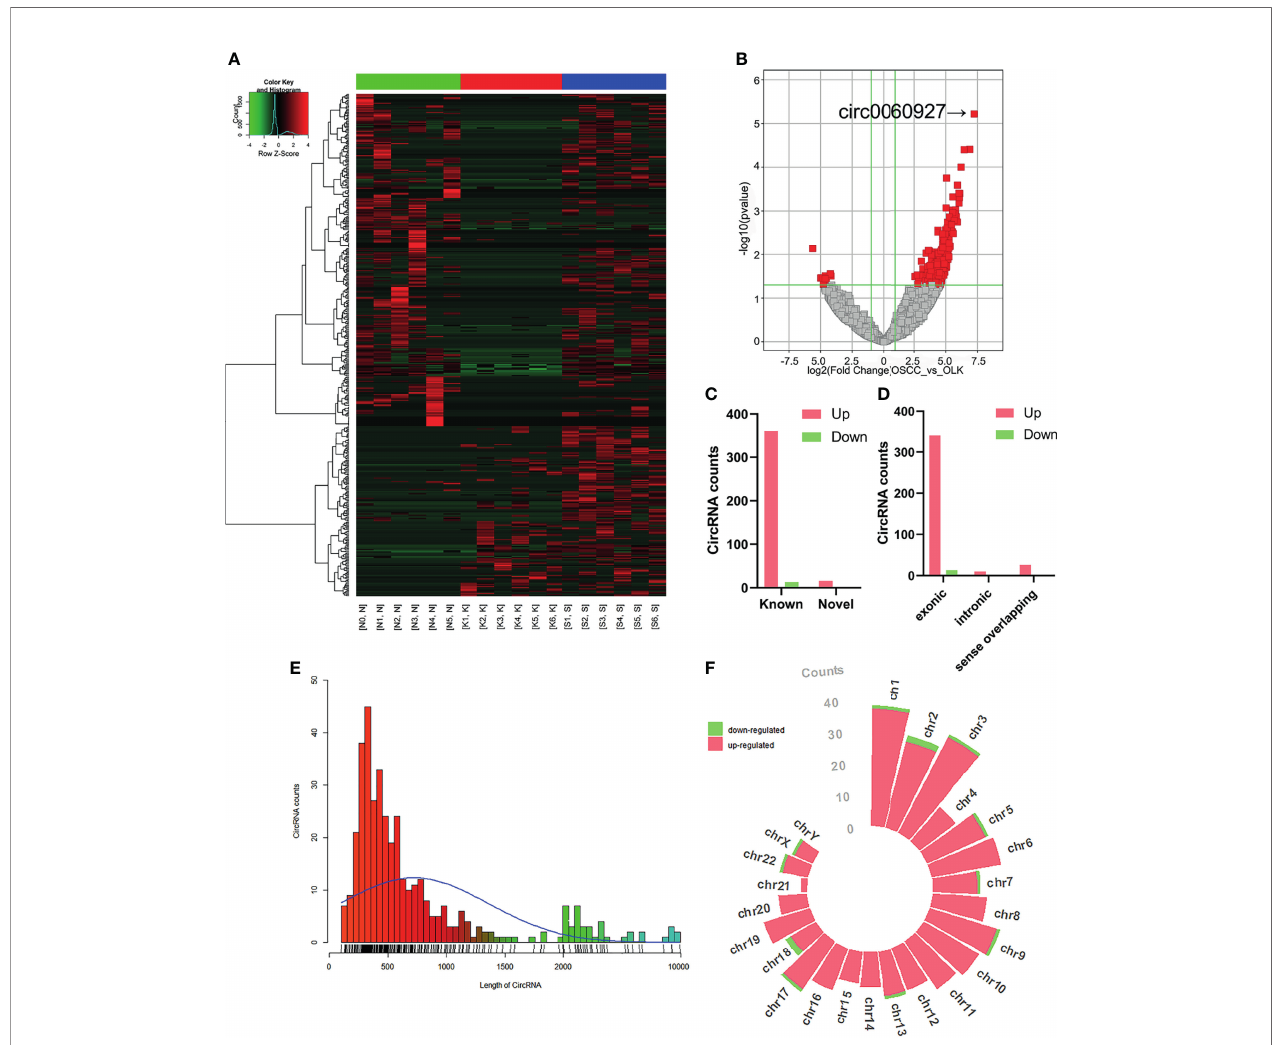
FIGURE 1 | Expression pro fi les and distribution characteristics of circRNAs in oral squamous carcinoma cell (OSCC) versus oral leukoplakia (OLK) tissues. (A) Hierarchical clustering analysis showed circRNA expression pro fi les that were different between OSCC, OLK, and NOM tissues. Hierarchical clustering analysis for 18 samples in a disease group (S1, S2, S3, S4, S5, and S6) (K1, K2, K3, K4, K5, and K6) and a control group (N0, N1, N2, N3, N4, and N5). (B) Volcano plot of signi fi cantly dysregulated circRNAs in OLK tissues. Red, eligible circRNAs (logFC ≥ 2.0, p -value < 0.05). (C) Filtered circRNAs were classi fi ed by whether they were newly discovered. (D) Signi fi cantly differentially expressed circRNAs were divided into three types according to host gene structure: exonic, intronic, and sense overlapping circRNA. Red, upregulated; green, downregulated circRNA. (E) Classi fi cation according to circRNA length. (F) Chromosome distribution of upregulated and downregulated signi fi cantly differentially expressed